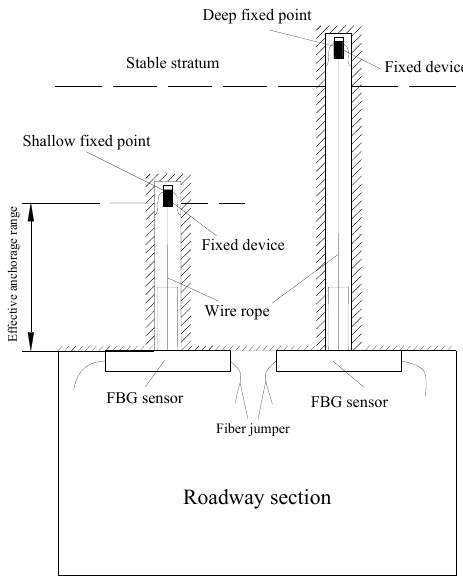
Figure 4. Schematic of FBG roof separation sensors implemented at field.